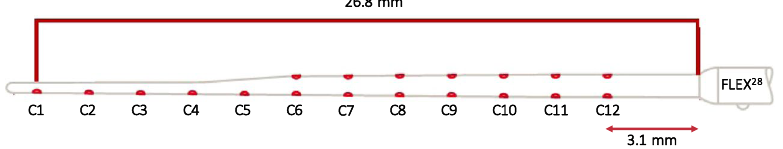
Figure 1. Flexible 28 mm electrode array (MED-EL, Innsbruck, Austria). The presented electrode array has a length of 28 mm from the silicone tip to the stopper. The distance between the first contact (C1, left side) and the stopper (ride side) is 26.8